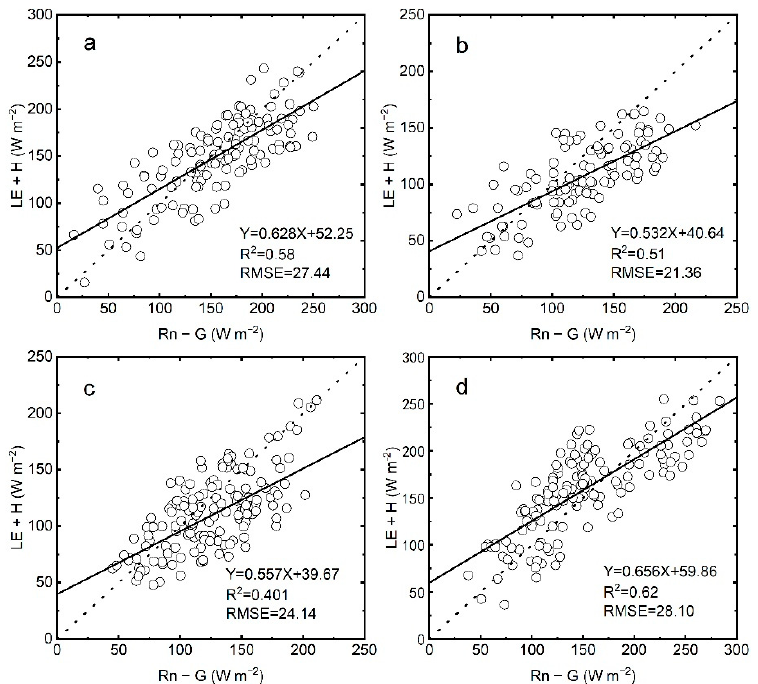
Figure 3. Energy balance closure of observation data at ( a ) alpine desert, ( b ) alpine meadow, ( c ) alpine meadow steppe, and ( d ) alpine steppe.